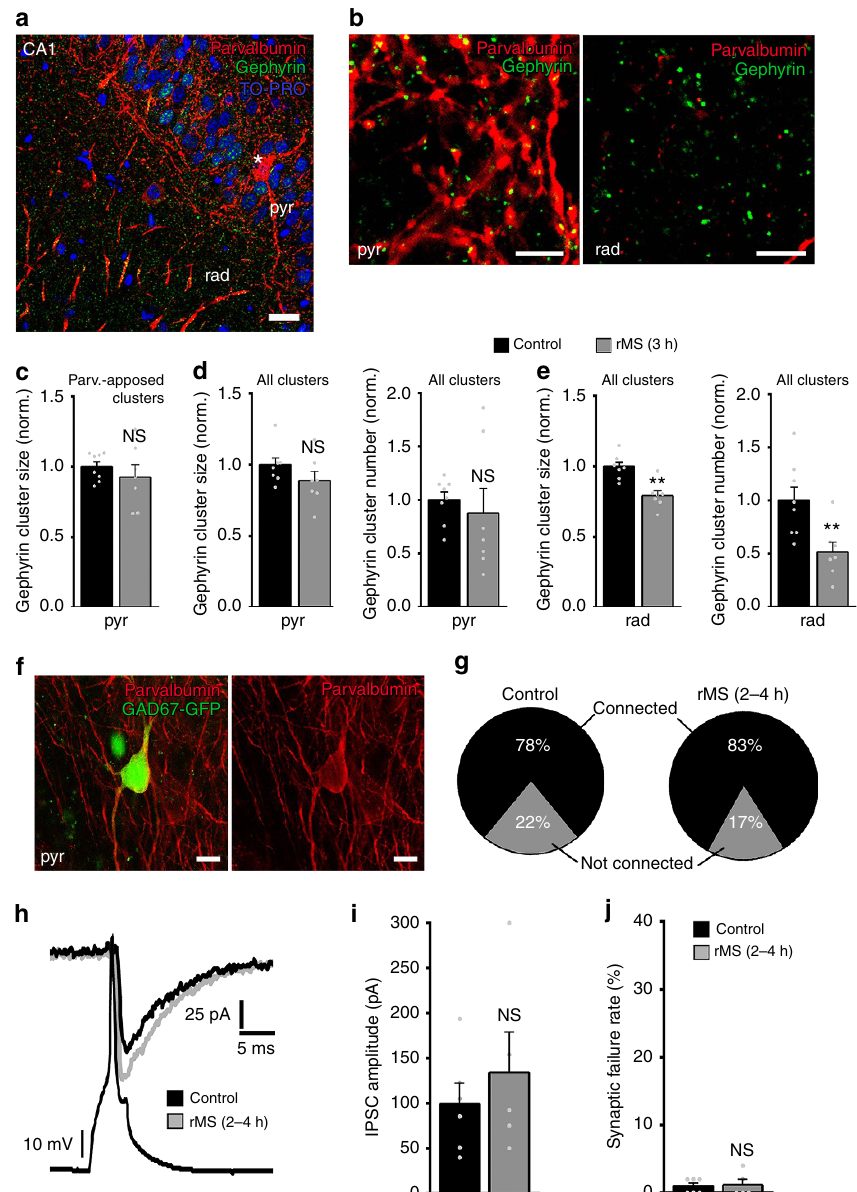
Figure 6 | rMS does not affect somatic inhibition. ( a , b ) Slice cultures stained for gephyrin (green) and parvalbumin (red). Note the parvalbumin-positive interneuron (asterisk in a ) in pyr. The axons of these neurons arborize mainly within the pyramidal cell layer ( b ; rad). The size of gephyrin clusters associated with parvalbumin-positive presynaptic boutons was assessed in pyr. Blue, TO-PRO nuclear stain. Scale bar in a , 20 m m, in b , 4 m m. ( c ) No significant difference in parvalbumin-associated gephyrin cluster sizes is observed in pyr between stimulated and non-stimulated slice cultures 3h after rMS (control, n ¼ 8 cultures; rMS, n ¼ 7 cultures; averaged data from three visual fields per culture; Mann–Whitney test). ( d , e ) The mean size and number of all gephyrin clusters are not significantly different in pyr. In the rad a significant reduction in gephyrin cluster sizes and numbers is observed after stimulation in the same set of cultures (control, n ¼ 8 cultures; rMS, n ¼ 7 cultures; averaged data from three visual fields per culture; Mann–Whitney test). ( f ) Paired recordings of parvalbumin-positive interneurons and CA1 pyramidal neurons were carried out in slice cultures prepared from GAD67-GFP mice. Parvalbumin-positive interneurons in pyr can be readily identified by the GFP signal in these preparations. Scale bar, 10 m m. ( g – j ) No major changes in inhibitory synaptic strength, efficacy and connectivity are observed in these experiments (control; n ¼ 6 connected pairs in four cultures, one connected pair excluded from analysis since series resistance changed significantly during recordings and reached Z 30M O ; seven of nine probed pairs connected; rMS, n ¼ 5 connected pairs in three cultures; five of six probed pairs connected; Mann–Whitney test). Individual data points are indicated by grey dots. Values represent mean ± s.e.m. (** P o 0.01; ns, not significant